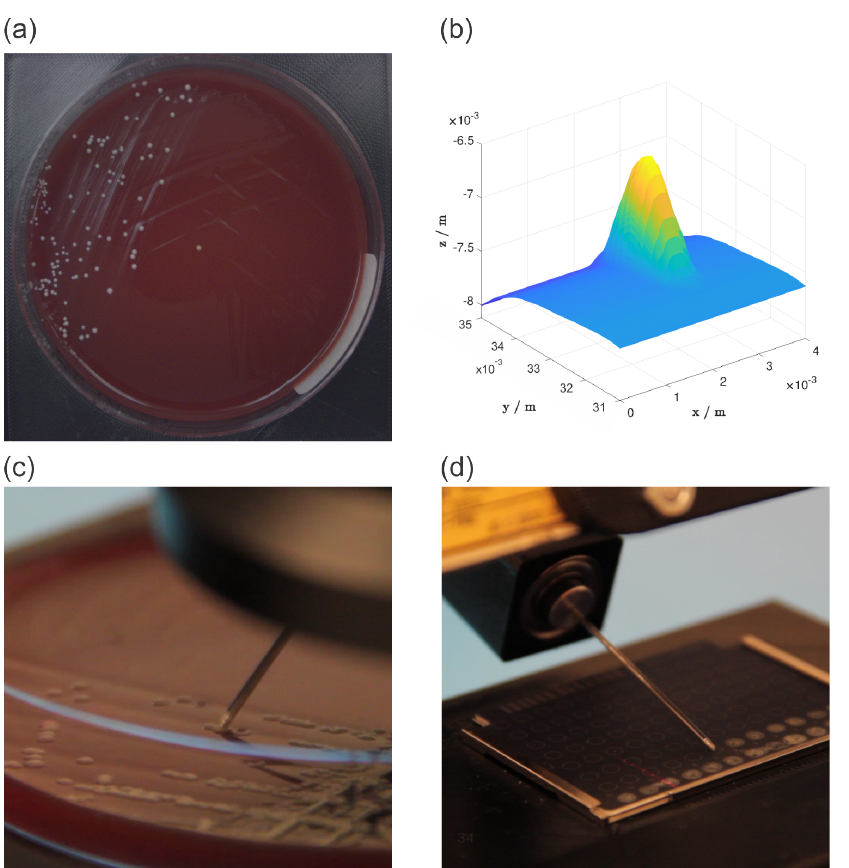
Figure 2. Overview of the experiment workflow: an image of a petri dish acquired with RGB camera ( a ), a 3D model of the selected bacterial colony generated from 2D laser profiles ( b ), the bacterial colony picking process ( c ), and the bacterial colony deposition process ( d